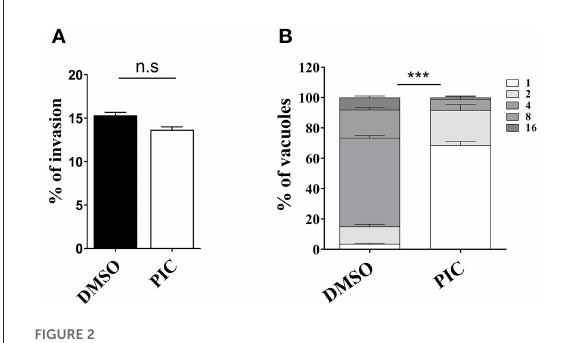
FIGURE2 Effect of piceatannol on parasite invasion and proliferation. (A) Graph of RH invasion suppression efficiency. RH infection was cultured in Vero cells containing 100 µ M piceatannol or DMEM and IFA was performed to calculate the rate of RH invasion. Statistical analysis of the plaque area was performed by Graph Pad Prism using Student’s t test. (B) Graph of RH proliferation inhibition efficiency. After infecting Vero cells with RH for 3h, infected cells were treated with 100 µ M piceatannol. The proportion of vacuoles containing 2, 4, 8 and 16 tachyzoites of the RH strain was calculated under fluorescence microscopy and the average value was taken three times. Statistical analysis of the plaque area was performed by GraphPad Prism using two-way ANOVA. n.s, non-significant, *** , p < 0.001.